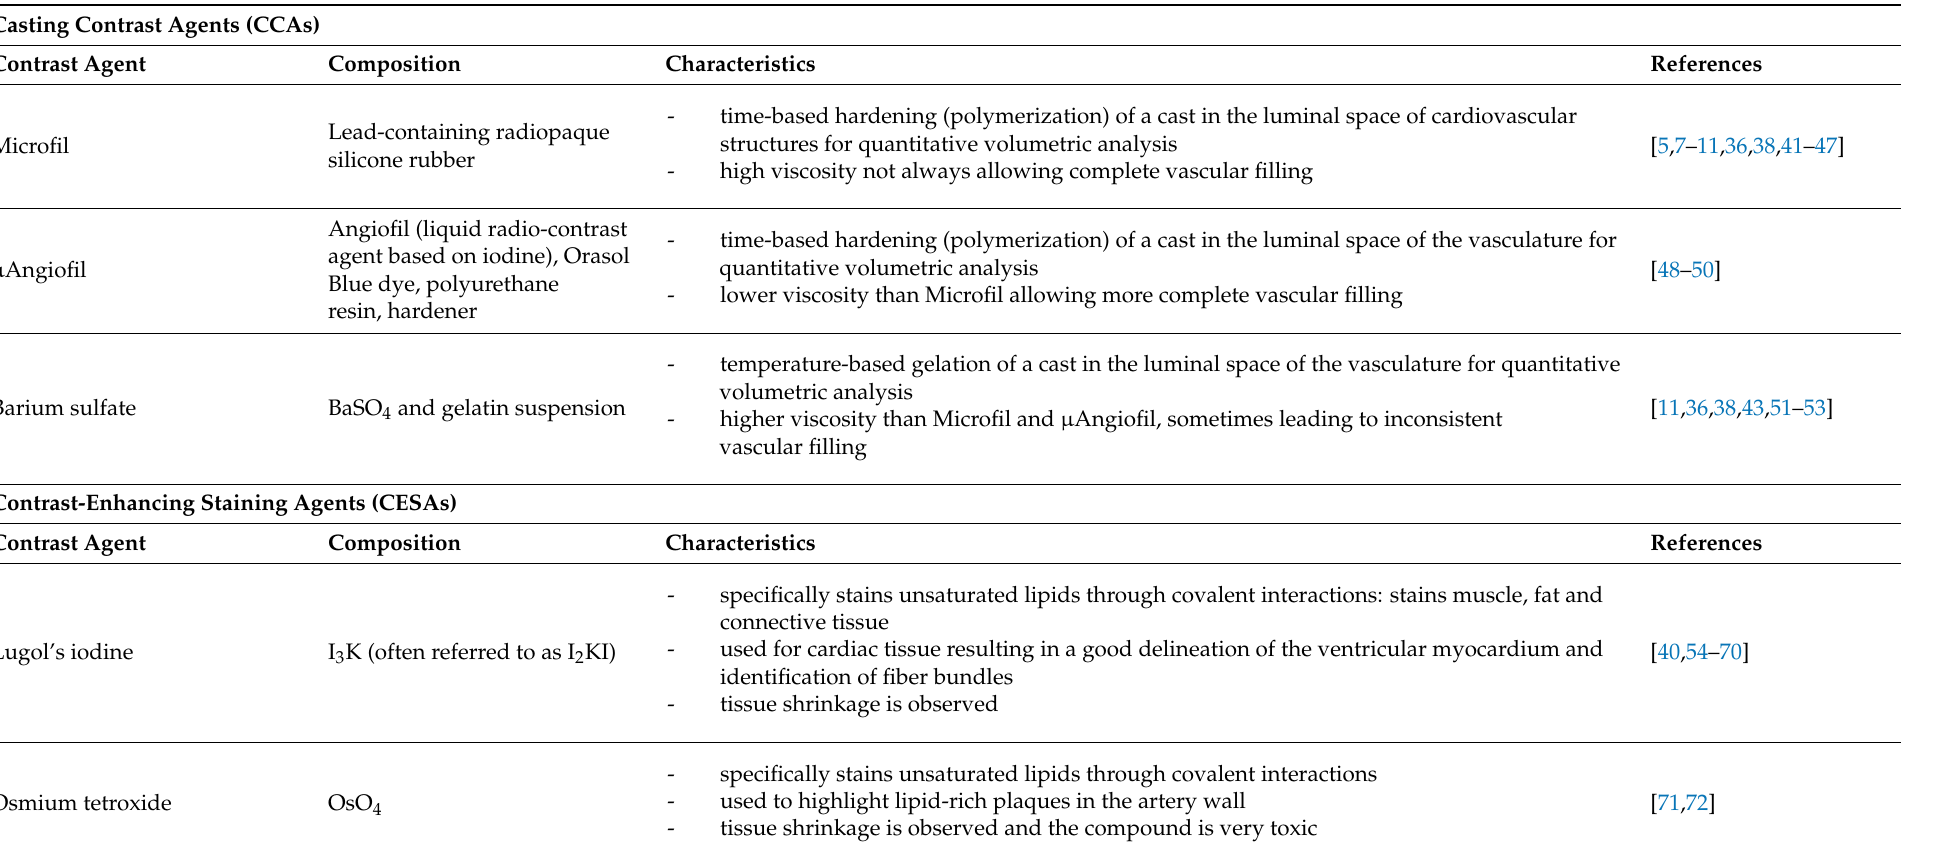
Table 2. Summary table for contrast agents used in CE-CT imaging of the cardiovascular system with their compositions, characteristics and references. Hf-WD POM: Hafnium-substituted Wells-Dawson